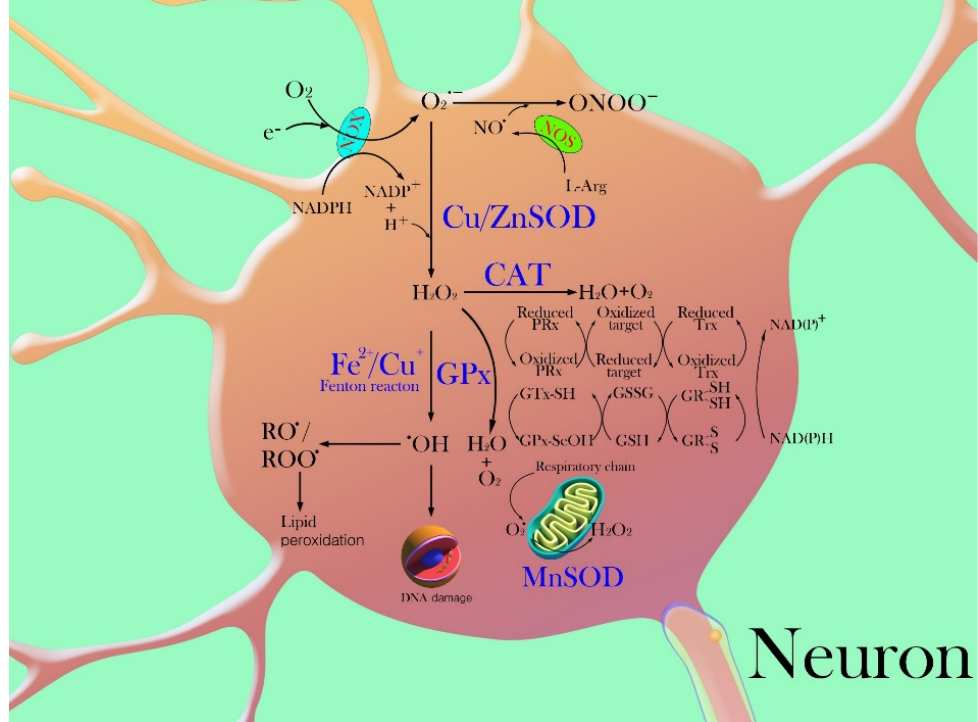
Figure 2. Enzymatic antioxidant defense system against the production of reactive oxygen species (ROS). Various pathways of cell death caused by ROS and its transformation are observed in brain injury. NADPH oxidase and mitochondrial respiratory transport chain are known as major cellular sources of the superoxide radical anion (O 2 − ). The superoxide radical anion reacts with nitric oxide (NO) to form the peroxynitrite anion (ONOO − ) which mediates oxidative modification of protein residues via an interaction with NO. The superoxide radical is dismuted by the superoxide dismutase enzyme (SOD) to form hydrogen peroxide. In addition, manganese containing superoxide dismutase (Mn-SOD) reduces the superoxide radical anion generated during the electron transport chain in the mitochondrial matrix. Catalase (CAT) and/or glutathione peroxidase (GPx) decomposes hydrogen peroxide to water and oxygen by enzymatic reactions. Hydrogen peroxide is decomposed into reactive hydroxyl radicals by reaction with catalytically active redox metals such as (copper and iron). Hydroxyl radicals can react with oxygen to form peroxyl or alkoxyl radicals which can lead to lipid peroxidation and react with DNA and primarily cause damage to DNA. Peroxiredoxins (Prx) and thioredoxin (Trx) act as redox-regulated proteins to additional redox relay bases.